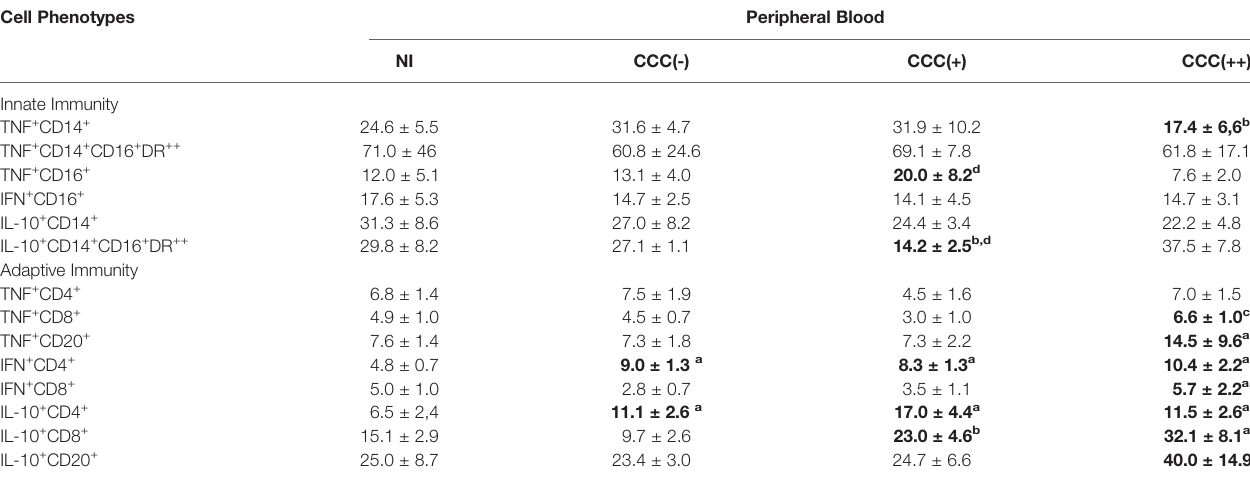
TABLE 2 | Ex vivo cytokine pro fi le of peripheral blood leukocytes from T. cruzi -infected cynomolgus macaques. Cell